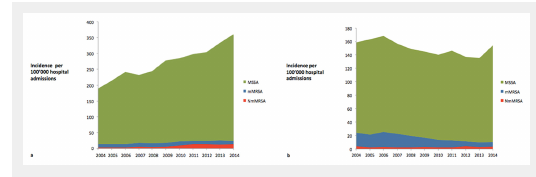
Incidence of methicillin-susceptible S. aureus (MSSA), non- multidrug resistant methicillin-resistant S. aureus (NmMRSA) and multidrug resistant methicillin-resistant S. aureus (mMRSA) per 100000 hospital admissions ( a ) in invasive isolates (excluding bacteraemic isolates) and ( b ) in